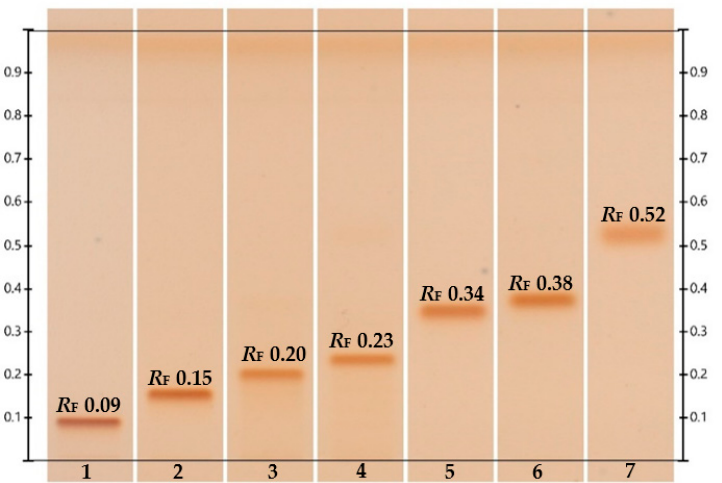
Figure 3. Silica gel HPTLC plate for rebaudiosides D, A, C, stevioside, rebaudioside B, dulcoside A and steviolbioside (tracks 1 to 7). Developed with ethyl acetate, methanol and formic acid (93:40:1 v / v / v ) with no saturation but activated with MgCl 2 at a relative humidity of 33%. The detection was performed after derivatization with a solution of 2-naphthol under white light.